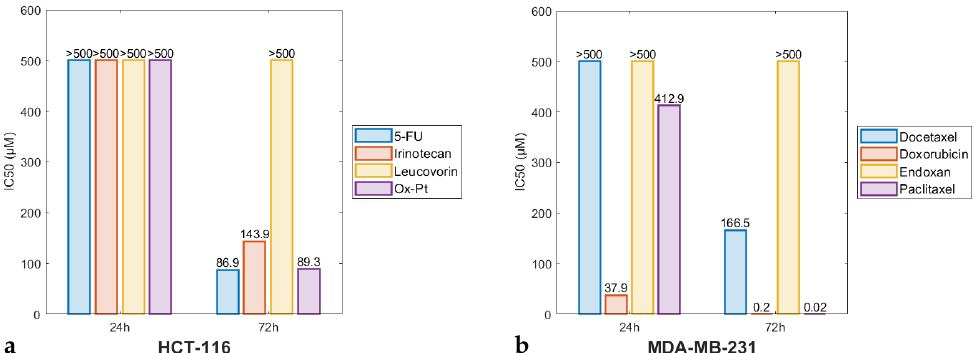
Figure 2. The toxicity effects against cells ( IC 50 values) of tested cytostatics on ( a ) HCT-116 and ( b ) MDA-MB-231 cells after 24 and 72 h of exposure to each drug (see figure legend). In Figures 3 and 4, the viability of HCT-116 and MDA-MB-231 cell lines is plotted out respectively (blue line and symbol) for each single-treatment scenario with respect to the relevant cytostatic concentration, following 72 h of incubation. Line plots for both cell lines are also provided, following 24 and 72 h of incubation, in Figures S1 and S2 respectively of the Supplementary Material